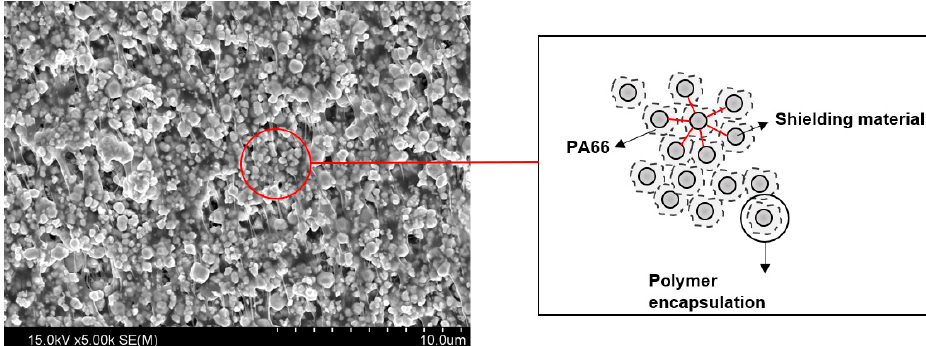
Figure 6. Comparative analysis of the cross-sectional images of single and composite materials of shield samples: ( a ) PW-85 (W) and ( b ) PWBaBi-80 (W, Ba, Bi). The circled portion labeled A exhib- ited the encapsulation phenomenon progressed by polymer coating around the particles of the shielding material, and B presents the state of the agglomeration between the particles of the com- posite material.